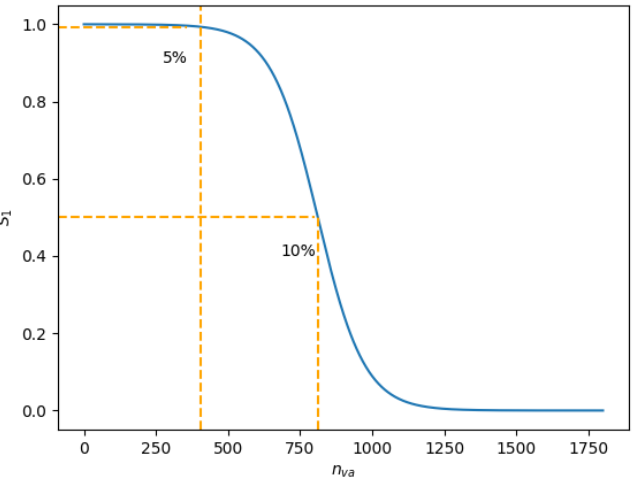
Figure 6. Illustrative example of the evolution of the S 1 metric as a function of the number of unknown points classified as abnormal ( n va ), with n up =